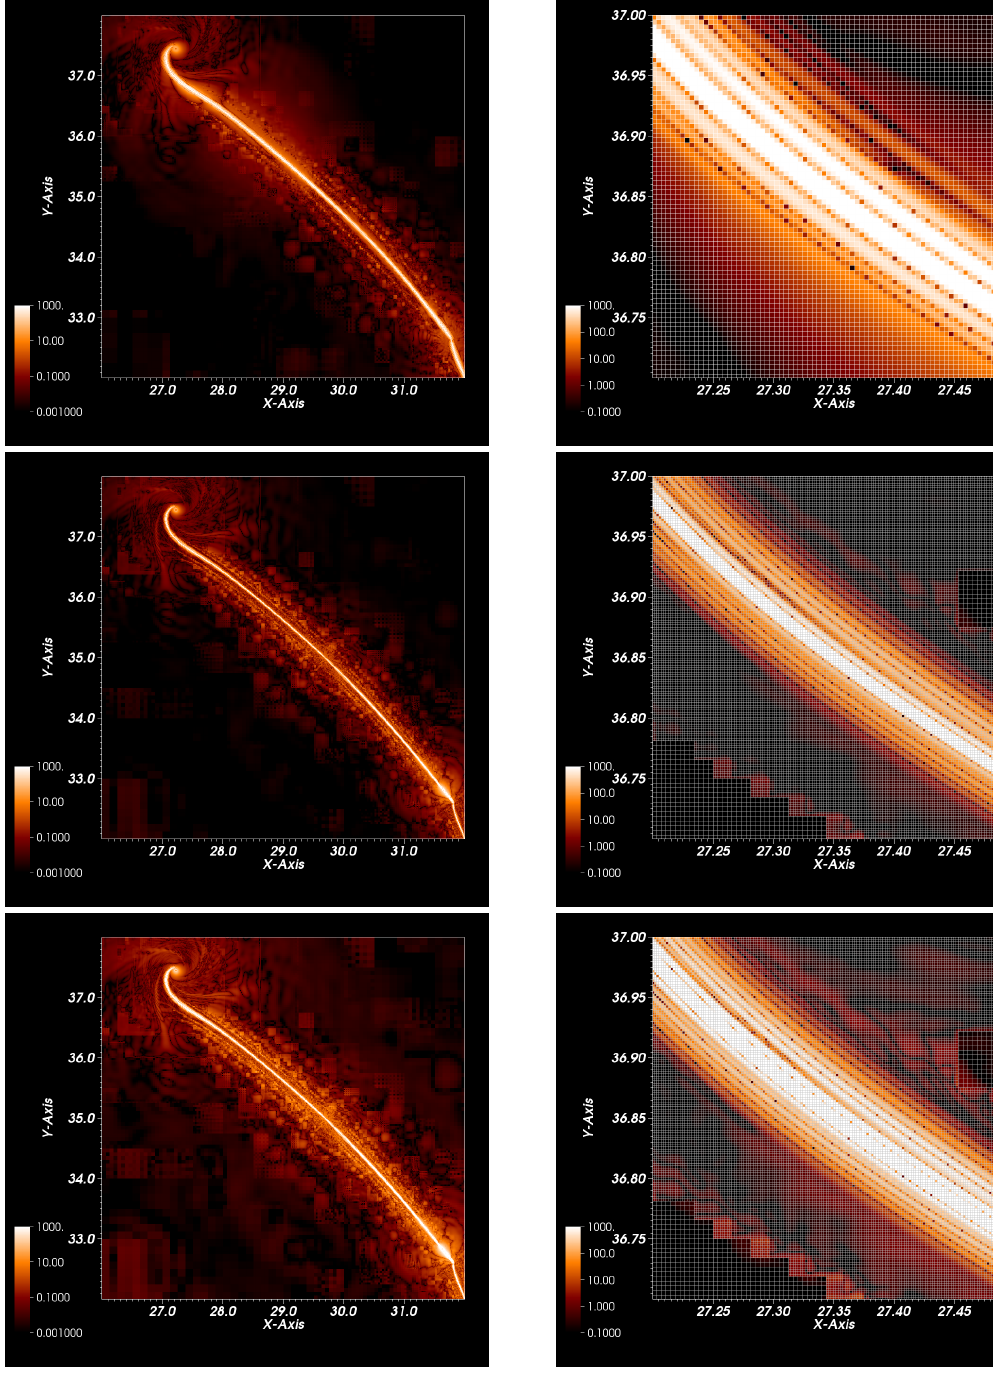
Figure 12 . Left column: the Hamiltonian constraint for the 6 D -A simulation in the xy plane at t = 22 . The upper panel shows the constraint obtained using 8 refinement levels only. The constraint with an additional 9th level is shown in the center panel and, amplified by a factor Q 2 = 4 for second-order convergence, in the bottom panel. Right column: a zoom-in of each of the left panels shows the constraint in a smaller region around the string. Here, we also display the grid structure in the form of a gray